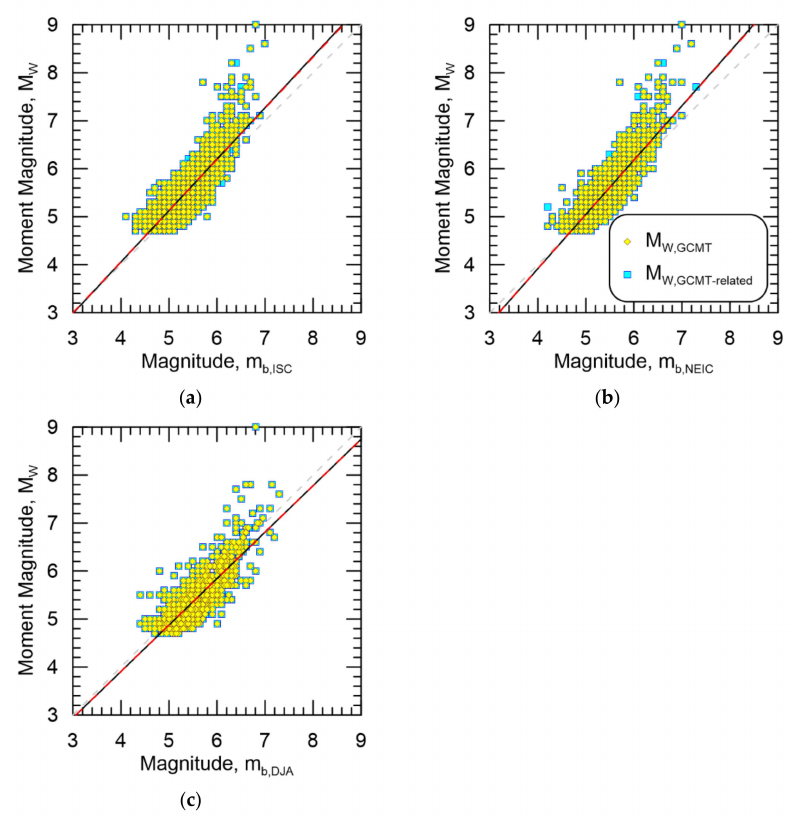
Figure 6. Resultant magnitude homogenization regressions for M W,GCMT-related against ( a ) m b,ISC , ( b ) m b,NEIC , and ( c ) m b,DJA . Data from M W,GCMT are also shown. Black line is the regression against M W,GCMT-related while the dashed red line is the regression against M W,GCMT . Conversely, regressions against M W,GCMT-hypothesis for against m b,ISC , m b,NEIC ,